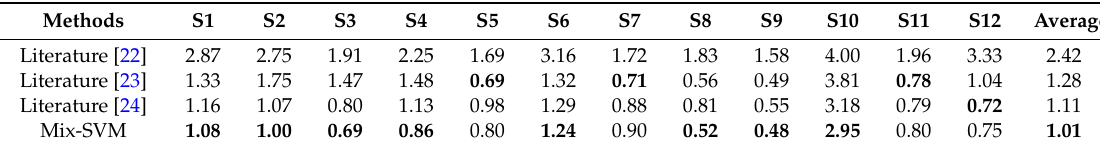
Table 1. The AAE on the 12 datasets. The unit is BPM.